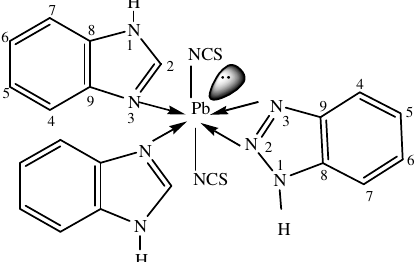
X ]complexes 2 2